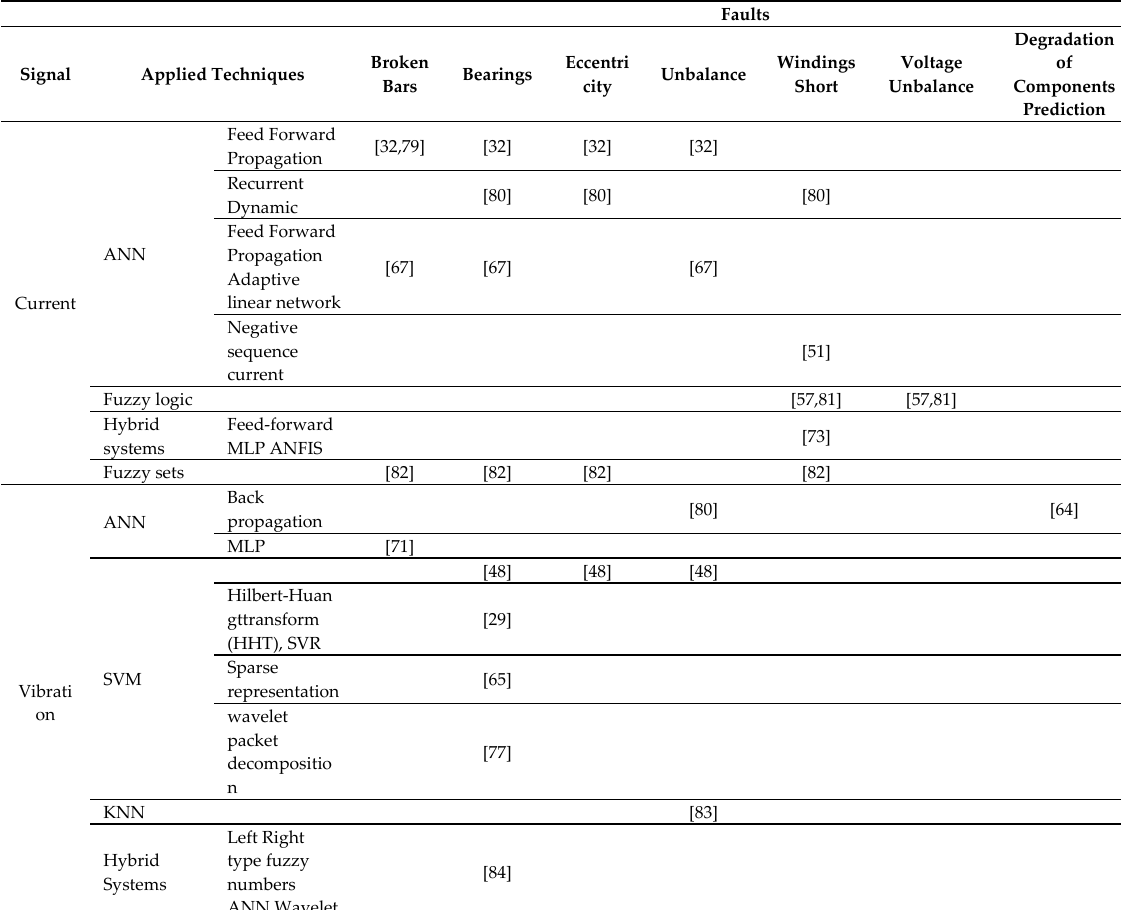
Table 16. AI techniques according to the type of fault analyzed.